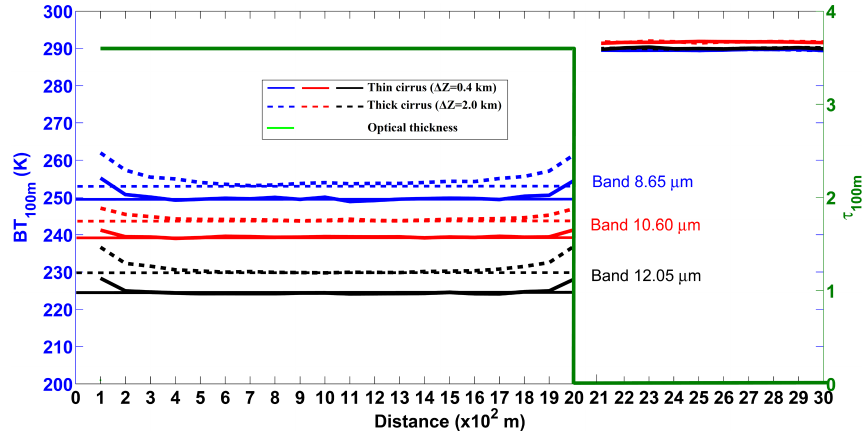
Figure 9. Brightness temperatures at the scale of 100m ( BT 100m ) as a function of the distance from the left cloud edge for a step cirrus cloud. The bold green line corresponds to the optical thickness at the scale of 100m ( τ 100m ); straight lines correspond to 1-D brightness temperatures and curves to 3-D brightness temperatures. Bold lines refer to brightness temperatures of the geometrically thin cirrus ( 1Z = 0 . 4km) and dashed lines to the geometrically thick cirrus ( 1Z = 2 . 0km); blue, red and black colors correspond to 8 . 65µm, 10 . 60µm and 12 . 05µm,